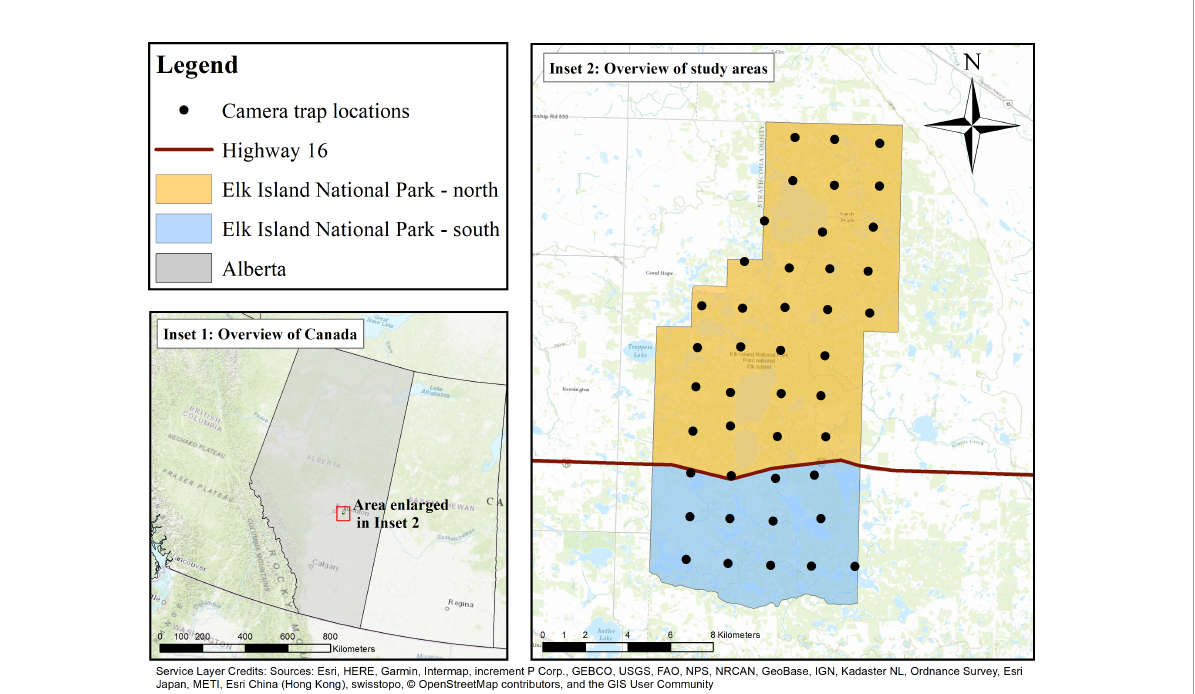
FIGURE 1 Camera trap survey in Elk Island National Park, Alberta, Canada. Cameras were deployed on a 2×2km 2 systematic grid, shown by black points. Elk Island National Park is bisected by Highway 16, shown by the red line. Both northern and southern portions of Elk Island National Park are surrounded by a 2.2m high perimeter fence, which restricts ungulate